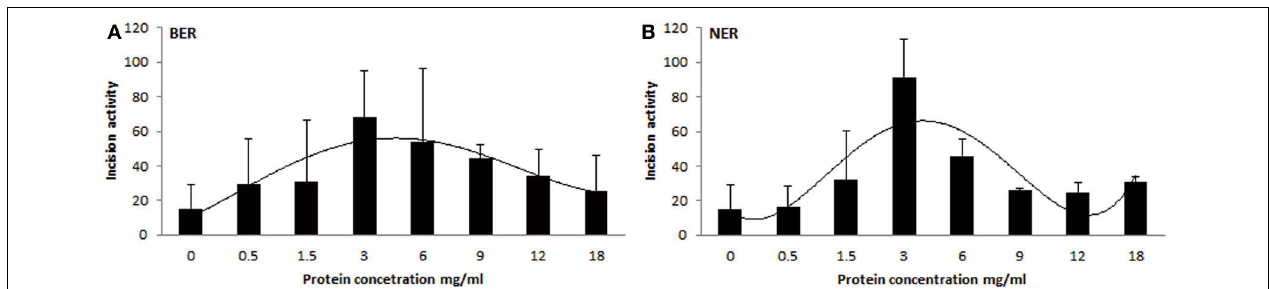
FIGURE 3 | Testing the extracts from DNA repair gene knock-out cells. Measurement of BER and NER activities in knock-out cells and wild-type control cells of the same origin. For (A) BER assay extracts were isolated from OGG1 − / − and OGG1 + / + mice livers; negative control (NC) represents